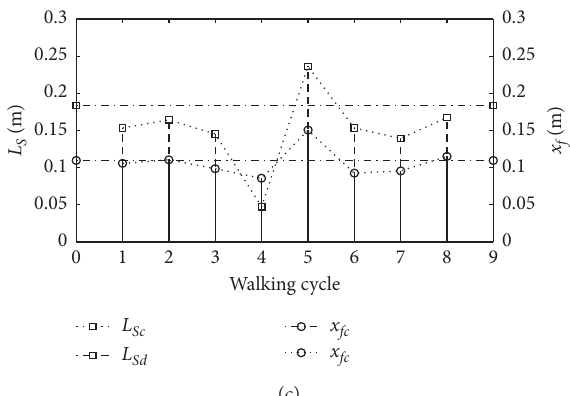
st experiment. (b) Variations f and L s in the 1